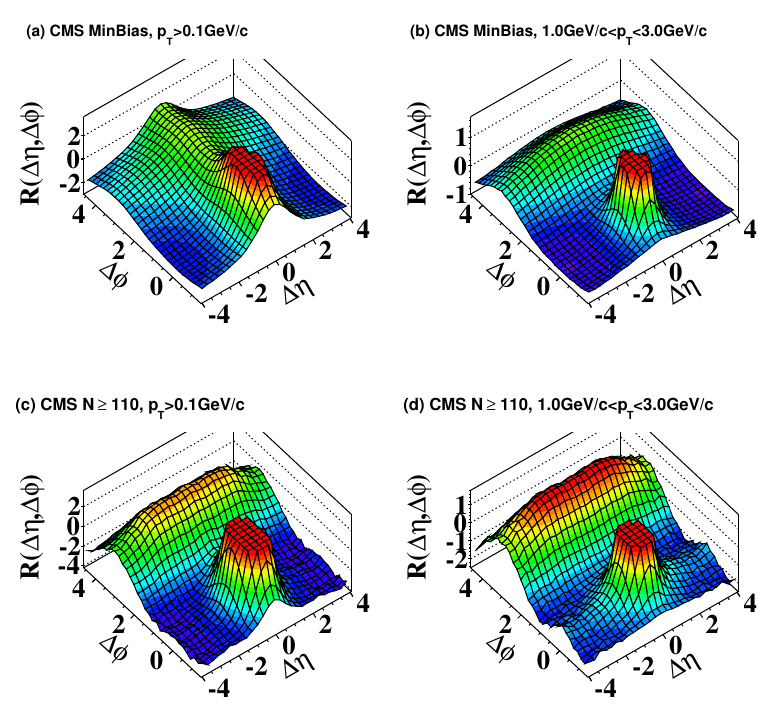
√ s = 7 TeV: ( a ) minimum bias offline ≥ 110) events with trk